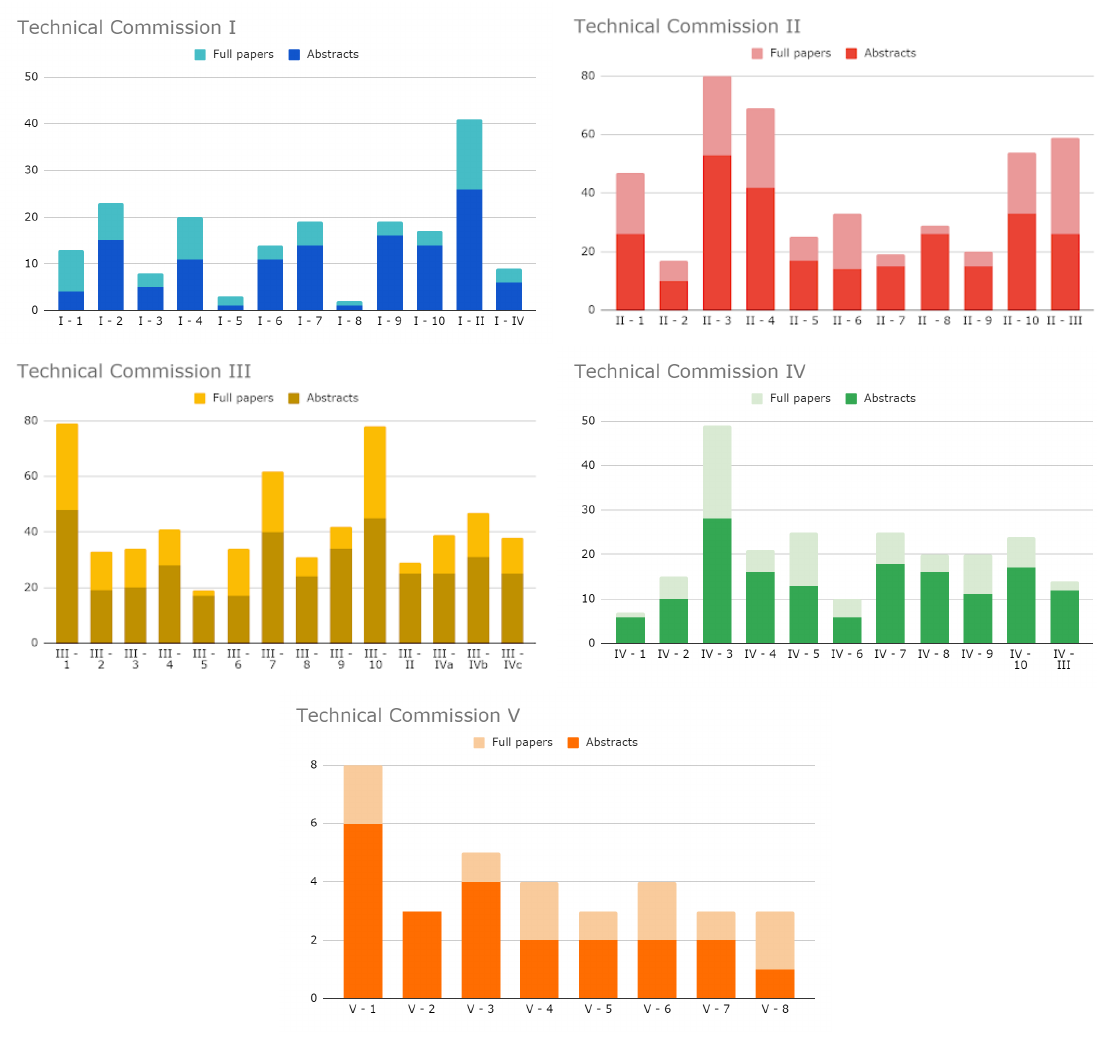
Figure 5. Submitted papers per Working Group.